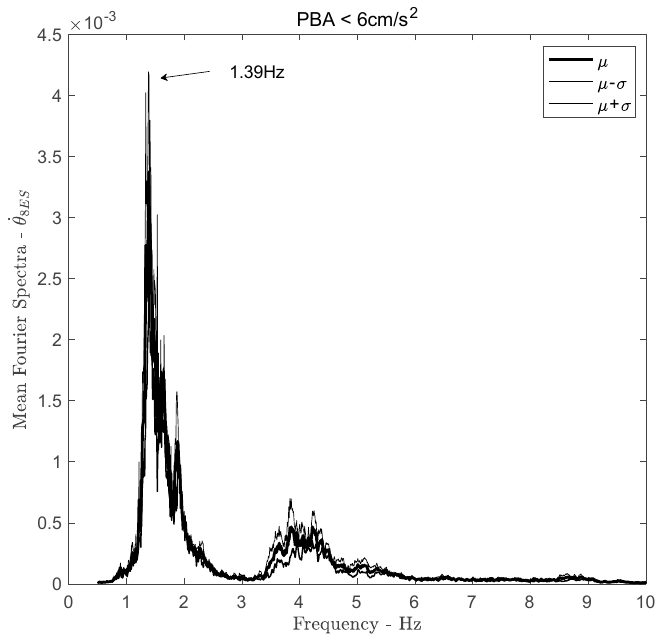
Figure 8. Fourier spectra of the rotational rate computed at the top of the structure. Bold line corresponds to the mean Fourier spectra of earthquakes with PBA < 6 cm/s 2 . Thin lines correspond to the +/ − standard deviation Fourier spectra.